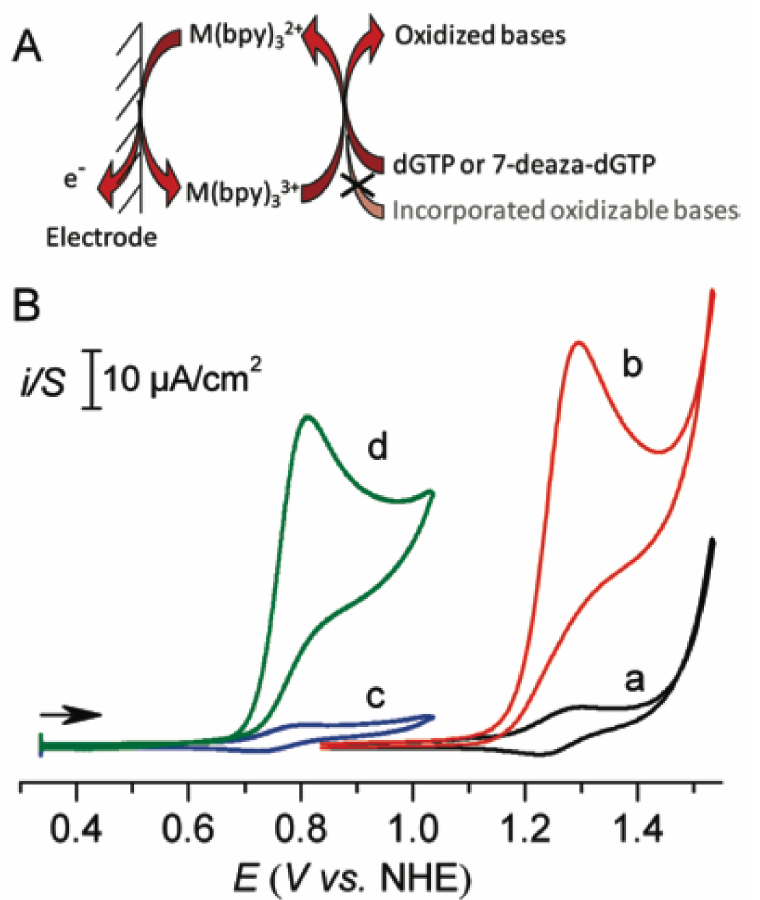
Figure 28. ( A ) Scheme principle of selective redox catalyst based on M(bpy ) 3 + Os) ( B ) Cyclic voltammetry at the scan rate of 100 mV/s recording (a) 20 µ M Ru ( bpy ) 2 + (b) 20 µ M Ru ( bpy ) 2 + and 150 µ M dGTP; (c) 10 µ M Os ( bpy ) 2 + 3 100 µ M 7-deaza-dGTP. All solutions were prepared in the form of Tris-HCl buffer (50 mM, pH 8.7). Reprinted with permission from reference [91]. Copyright 2009 American Chemical